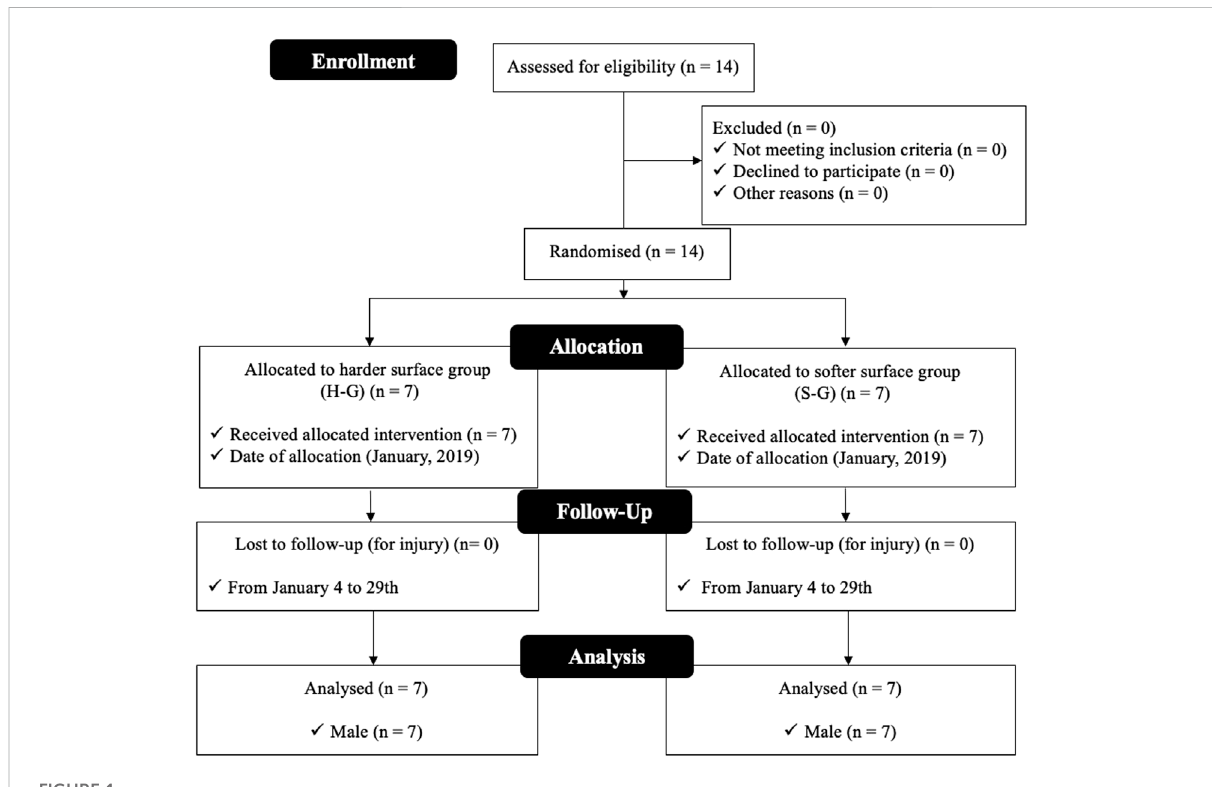
FIGURE 1 Flowchart of